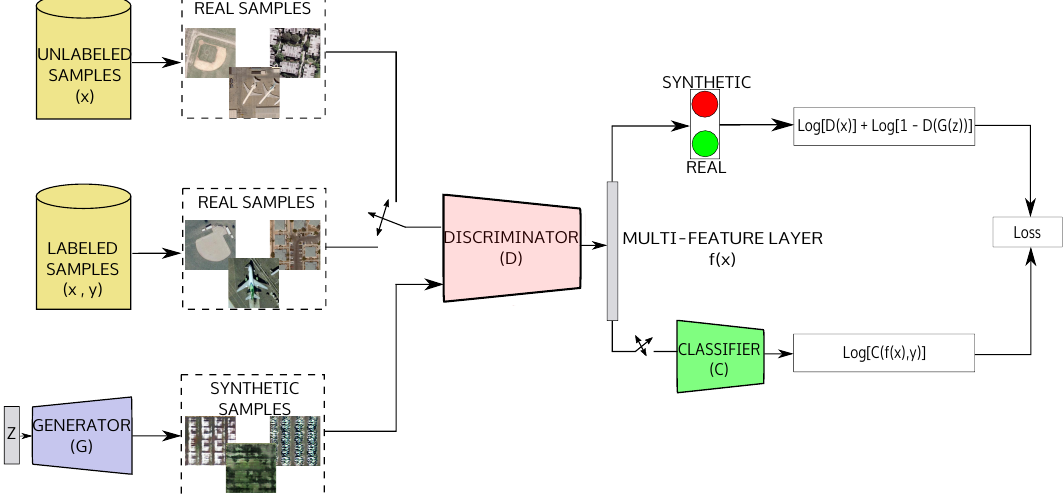
Figure 1. Overview of the SSRL-GAN method. The Generator ( G ) learns to synthesize images to fool the Discriminator ( D ), which learns to distinguish between real and synthesized images. The semi-supervised procedure is performed by switching between unlabeled and labeled real images. When labeled images are used, features f ( x ) are extracted from the multi-feature layer and used as input to the Classifier ( C ) which will influence the GAN objective function. training data is labeled or not. In the first, pure unlabeled